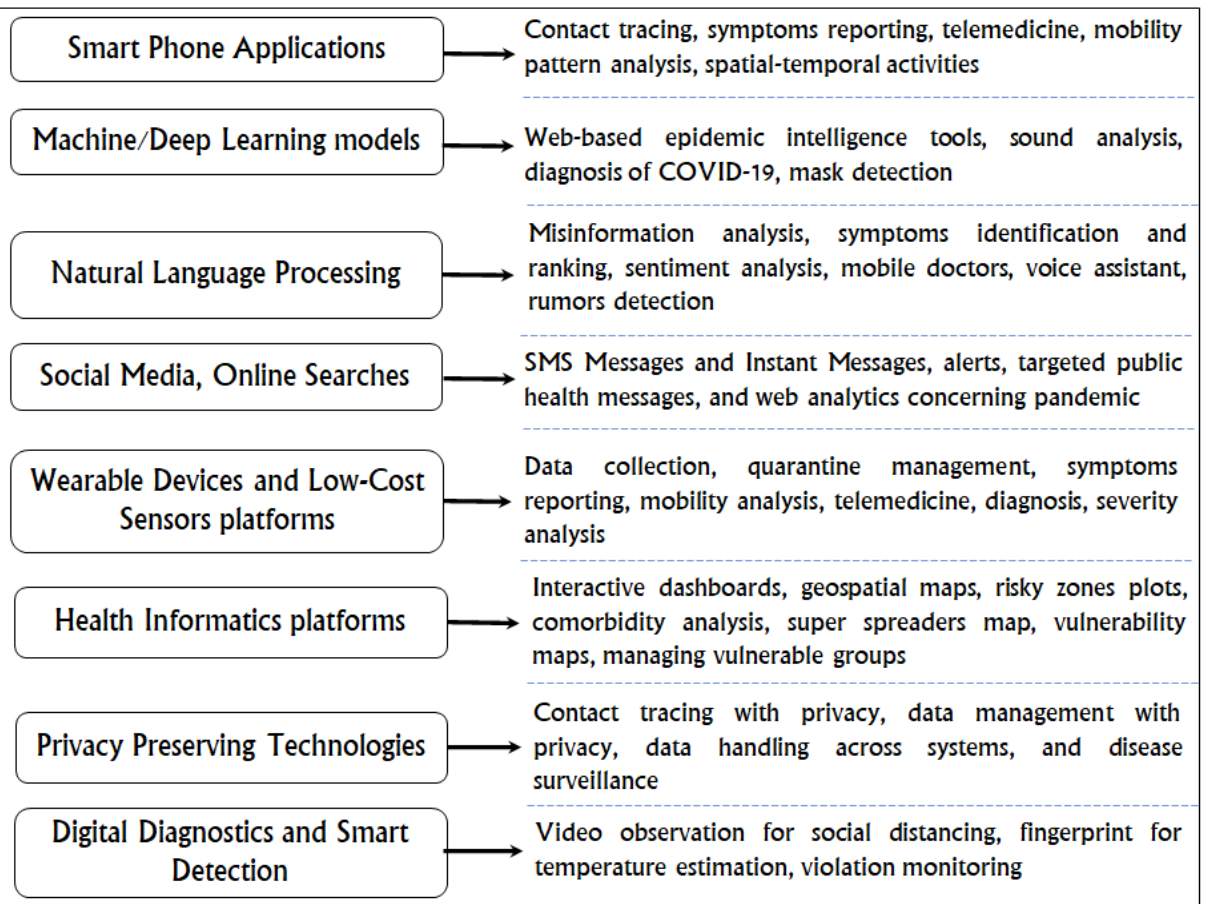
Figure 5. Overview of key technologies other than FL that have contributed to handling the pandemic (Adopted and enhanced from